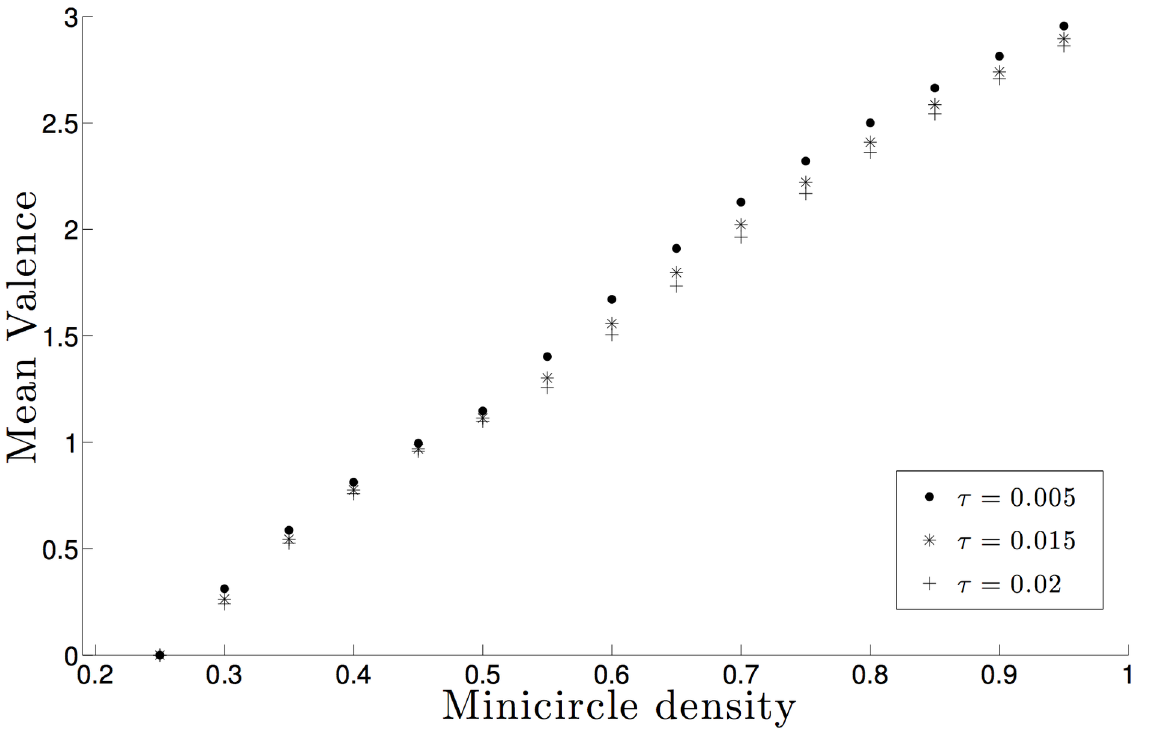
Fig 2. Estimation of the mean minicircle valence as a function of the minicircle density for biologically significant radii. The sample size for each data point is 10 5 and the sizes of the error bars are less than the sizes of the plotted data points.